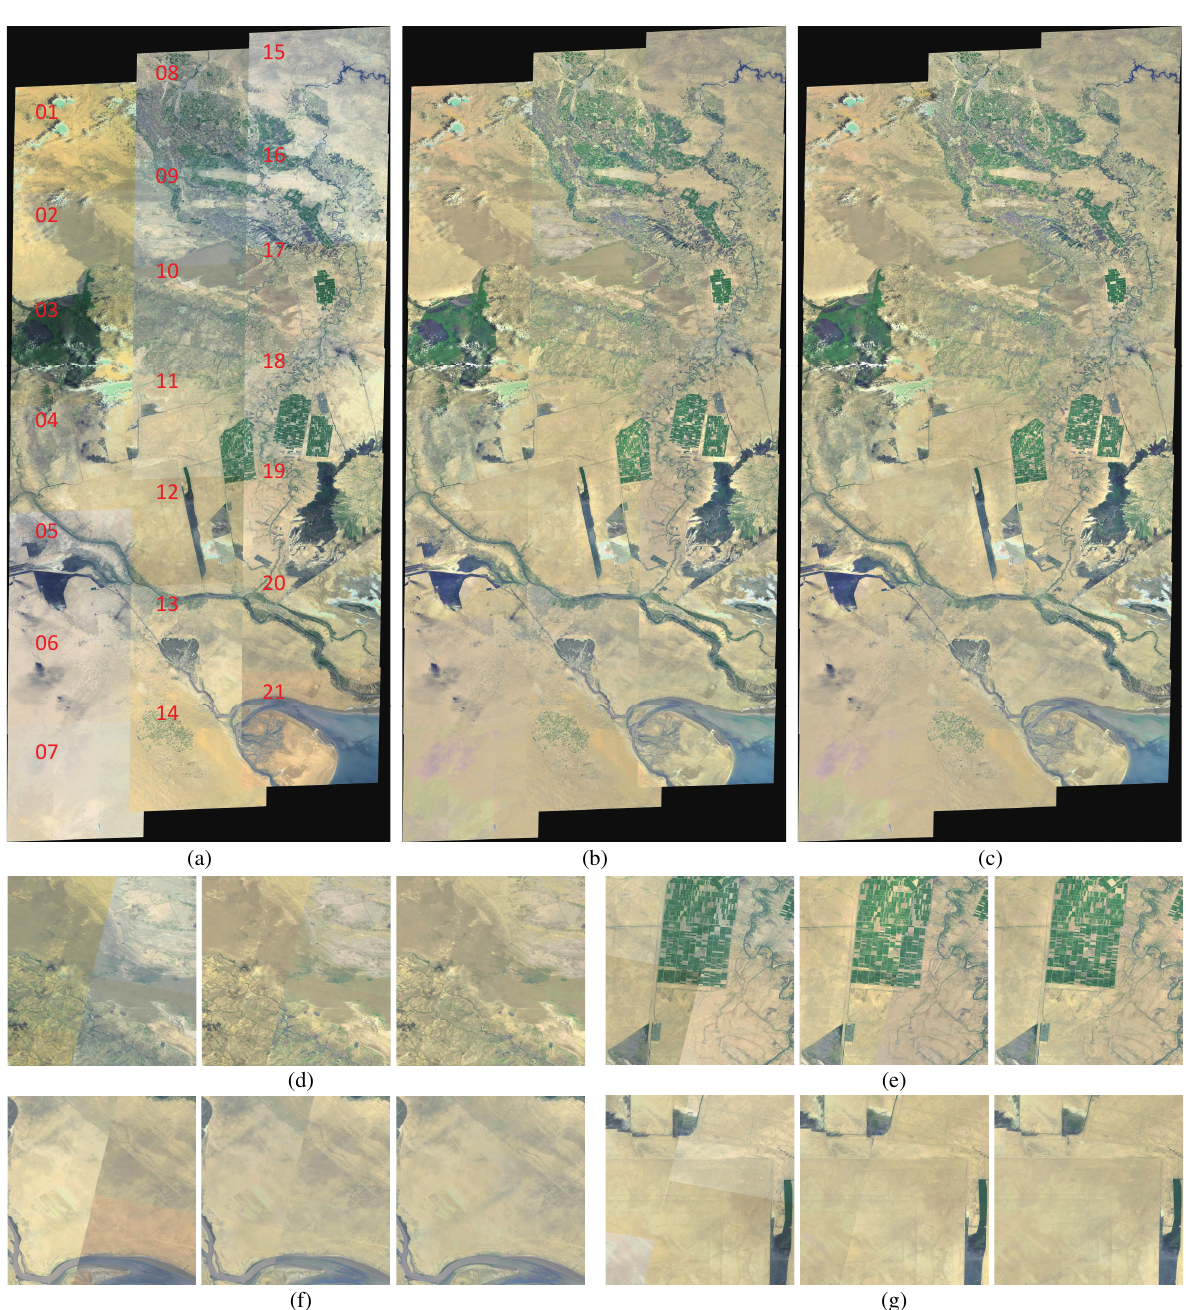
Figure 8. The experimental results on three strips of multi-temporal images: (a) the mosaicked image by a simple superposition from 21 input images; (b) the finally corrected results based on the maximum reference subset { 12 ; 13 ; 14 ; 19 ; 20 } ; (c) the mosaicked image by applying a multi-band blending on the finally corrected images in (b) with the open source software Enblend ; (d)-(g) four enlarged representative regions clipped from the mosaicked images before and after consistent tonal correction and those after applying multi-band blending on the corrected result, as shown in (a) , (b) and (c),